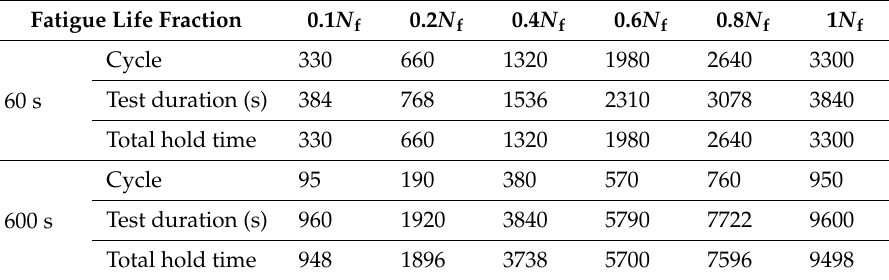
Table 1. Creep-fatigue parameters of tempered ferritic 9Cr